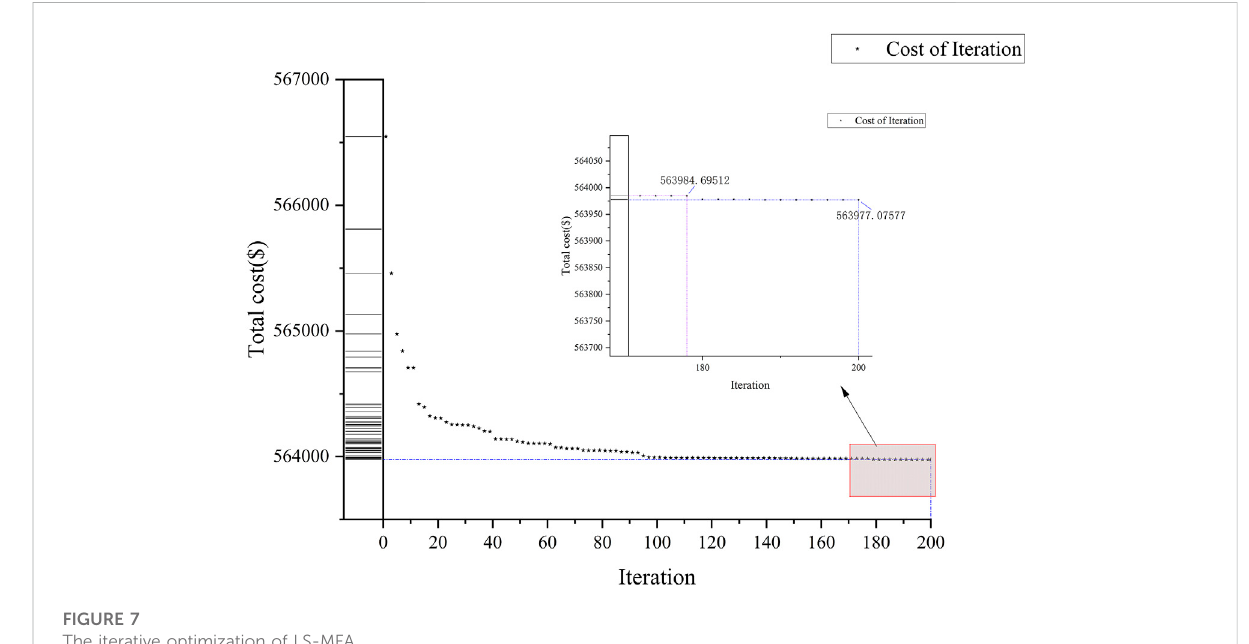
FIGURE 7 The iterative optimization of LS-MFA.